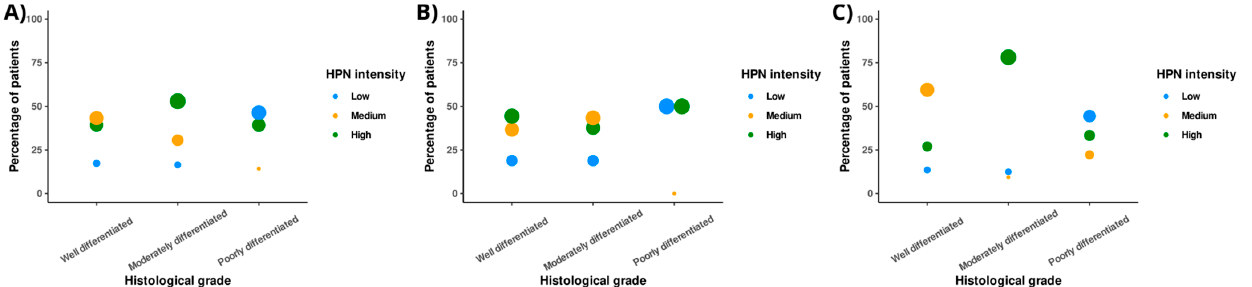
Figure 1. Distribution of Hepsin staining intensity in patients with different grades of tumor differentiation. ( A ) Percentage of patients in the overall cohort with different Hepsin staining intensity in each of the three grades of tumor histological differentiation. ( B ) Percentage of localized patients with different Hepsin staining intensity in each of the three grades of tumor histological differentiation. ( C ) Percentage of metastatic patients with different Hepsin staining intensity in each of the three grades of histological tumor differentiation. HPN: Hepsin.